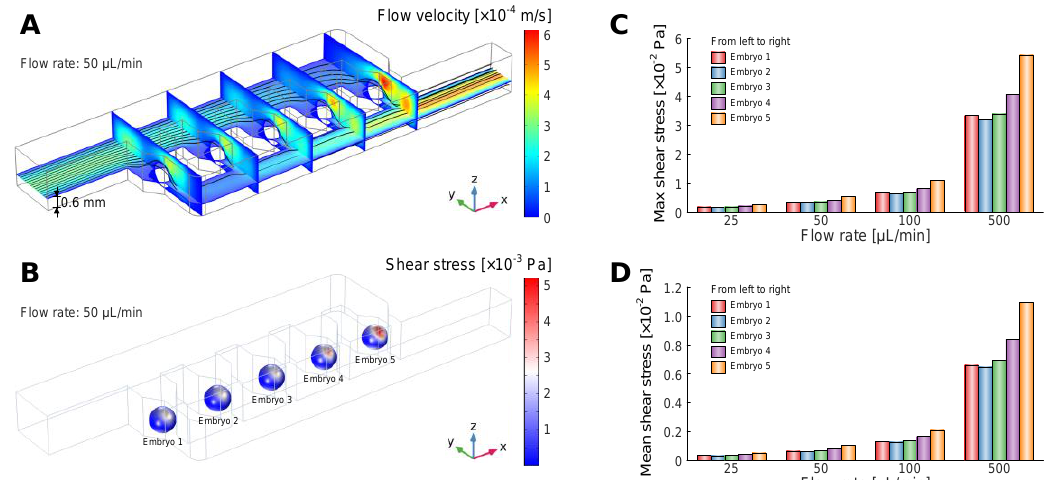
Figure 5. Computational fluid dynamics (CFD) simulations of flow velocity and shear stress for embryo immobilization in the microfluidic device. ( A ) Contour plots and stream lines of cross-sections in the xy -plane (across the horizontal middle of immobilized embryos, i.e., 0.6 mm above the channel bottom) and yz -plane (across the vertical middle of each immobilized embryo) showing the flow velocity across the embryo-culturing channel immobilized with five embryos. Flow rate was set to 50 µ L/min in simulation. ( B ) Contour plot of shear stress over the surfaces of five immobilized embryos. Flow rate was set to 50 µ L/min in simulation. ( C , D ) Simulated maximum and mean values of shear stress over each embryo at applied flow rates: 25, 50, 100 and 500 µL/min.